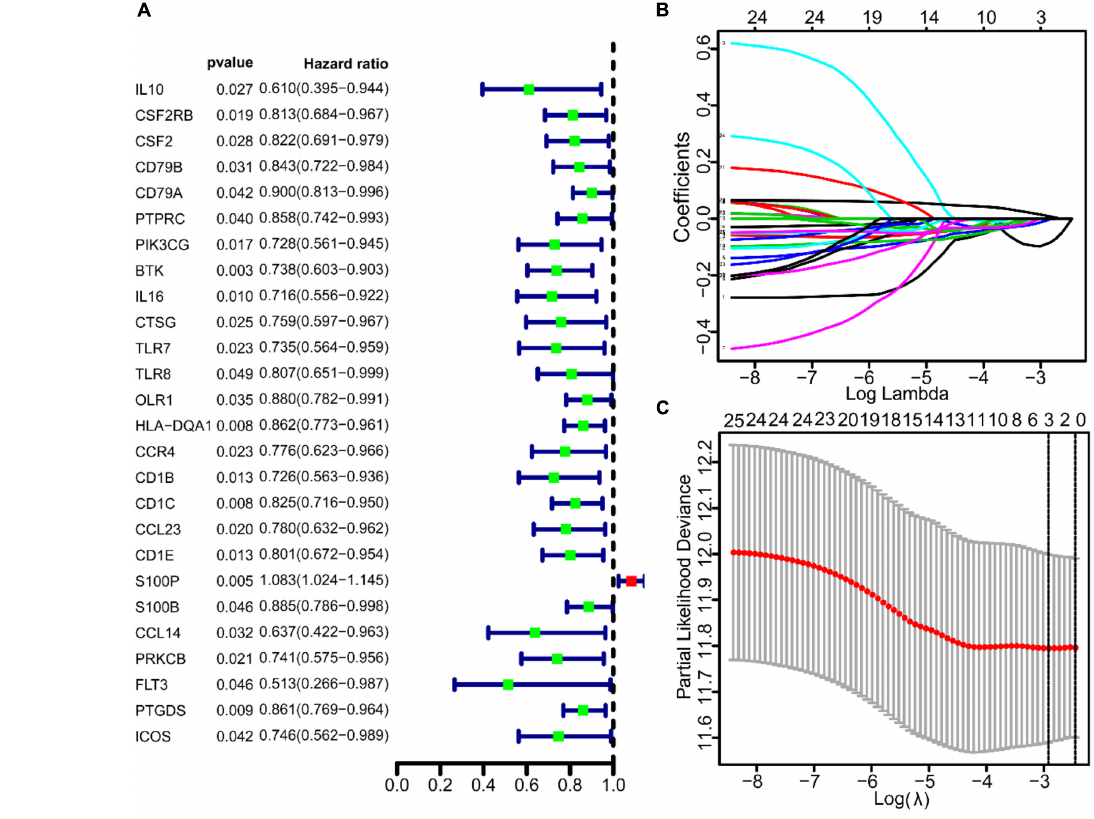
FIGURE 3 | The univariate COX and lasso analysis of immune genes. (A) The univariate COX analysis of 93 IRGs. (B,C) The lasso analysis of 26 immune genes.